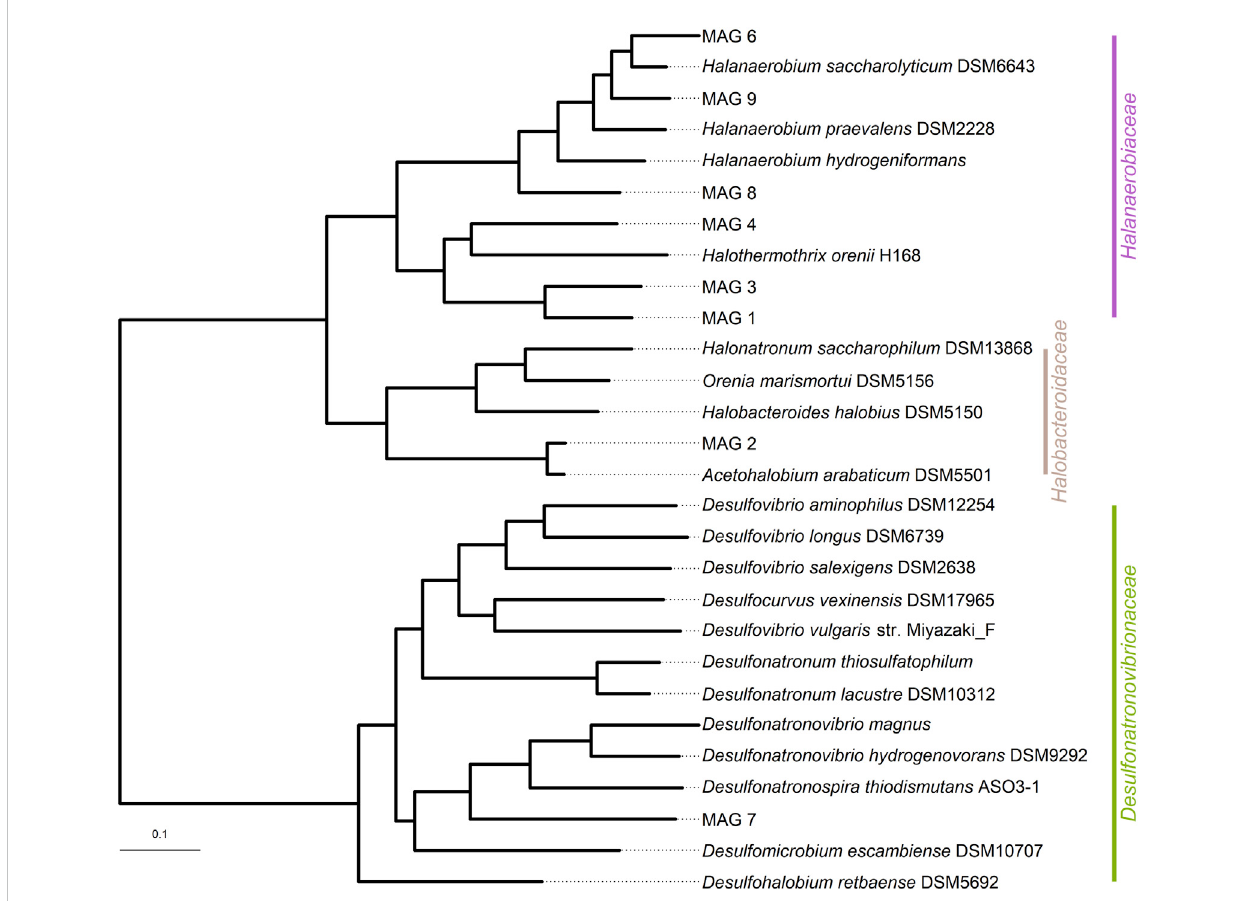
FIGURE 4 Phylogenetictreebasedon49core,universalgenesde fi nedbyCOG(ClustersofOrthologousGroups)genefamiliesusingthespeciestreefunction of KBase. The bar represents the genetic